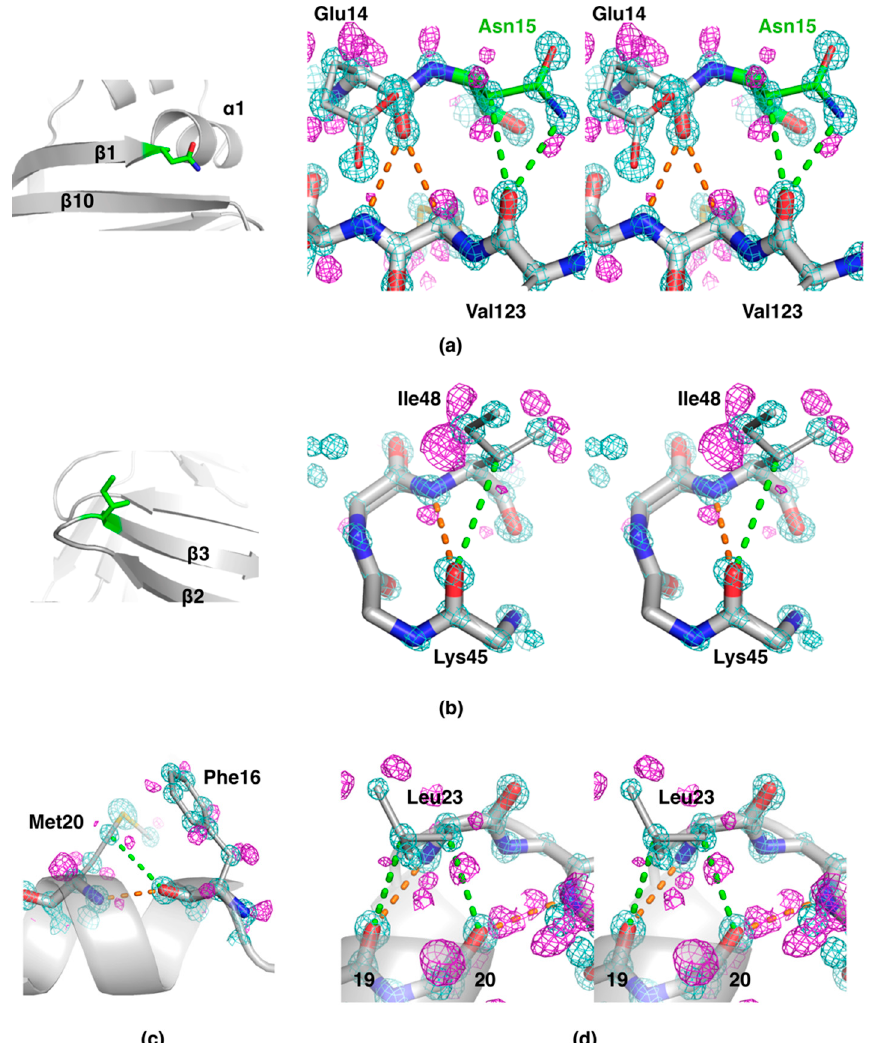
Figure 3. Details of protein backbone interactions from sub-atomic resolution electron density maps.